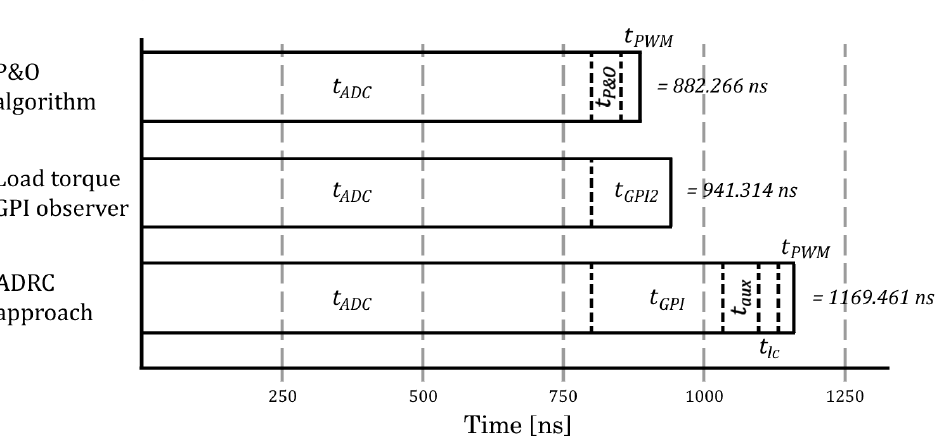
Figure 15. Timing diagram of the software.